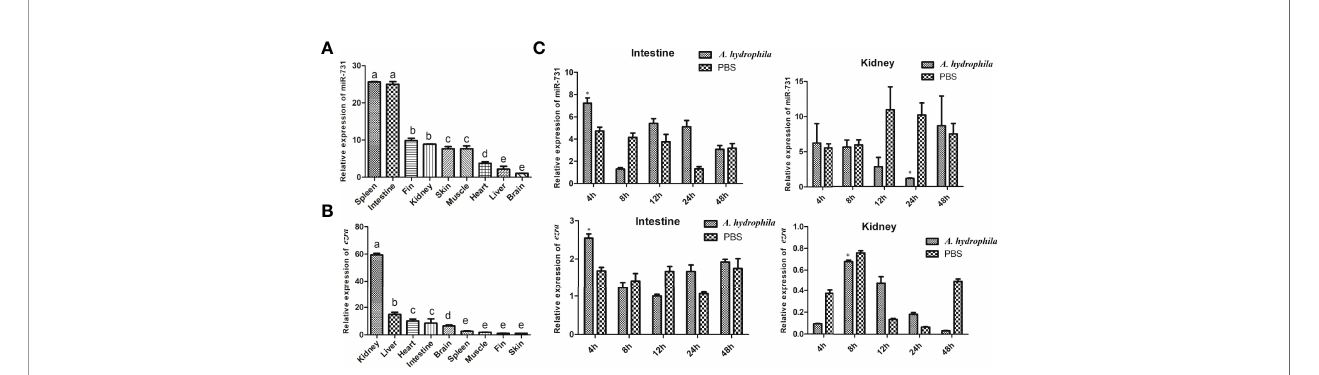
FIGURE 5 | Analysis of miR-731 and ezra expression by qRT-PCR. (A, B) in 9 tissues of grass carp. (C) in grass carp intestine and kidney 4, 8, 12, 24 and 48 h after A. hydrophila infection. All values represent the mean ± SD of three independent experiments. Different lowercase letters indicate statistically signi fi cant differences (p < 0.05), asterisks indicate signi fi cant differences (*p < 0.05).